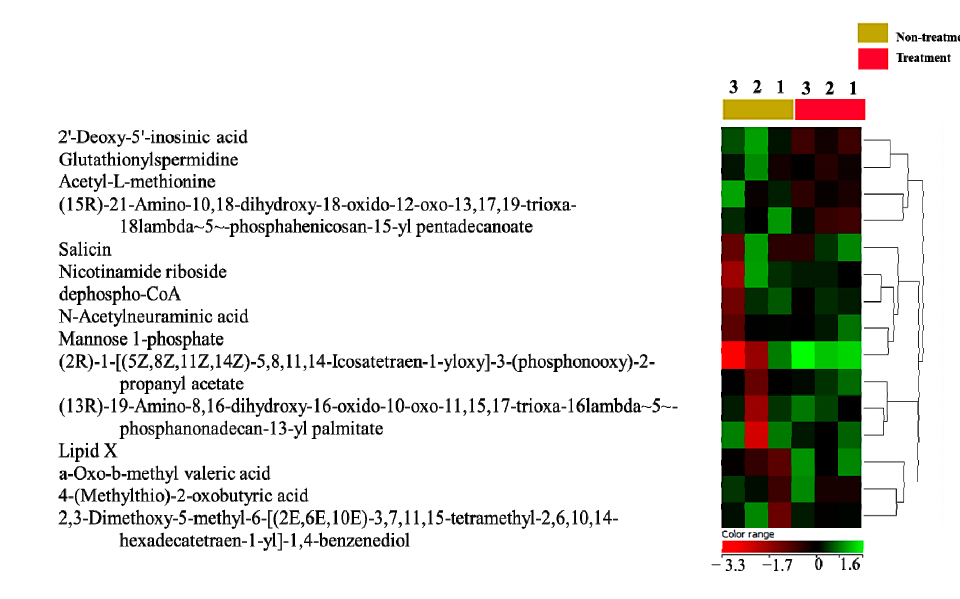
Figure 3. Excluded culture media backgrounds at the experimental time points. A Venn diagram showing the treated ( n = 1949) and non-treated ( n = 449) significant features at different time points (0, 1, 2, 6, 8, and 24 h). A group of 1760 features was consistently dysregulated 24 h post-treatment.